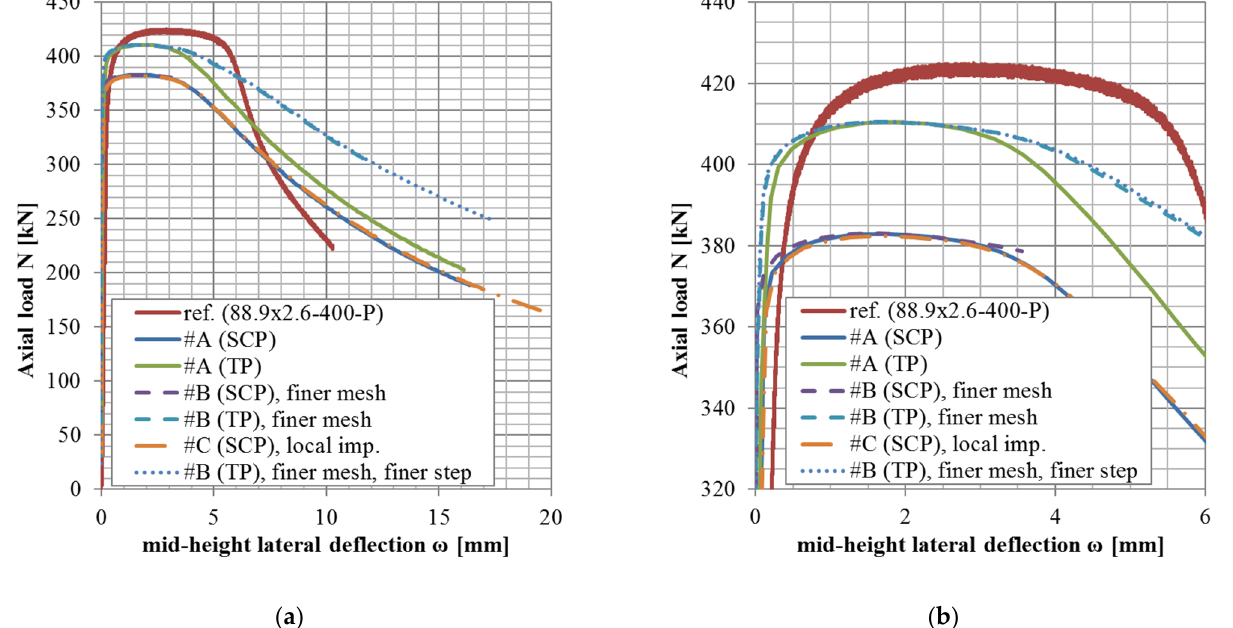
Figure 4. Experimental and FE loads vs. midheight lateral deflection curves of 88.9 × 2.6-400-P [38]: ( a ) whole*; ( b ) zoomed.